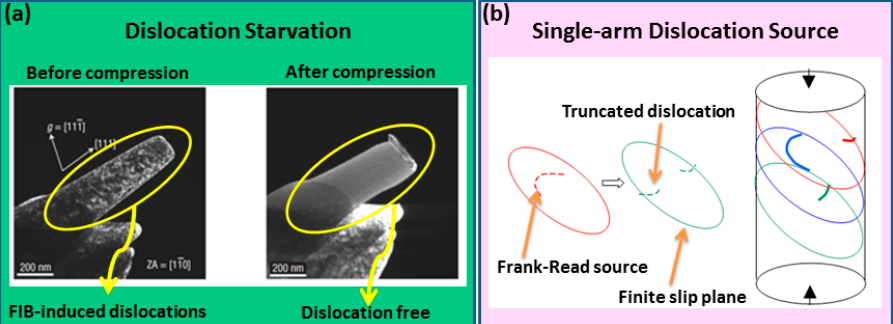
Figure 1. ( a ) Dislocation starvation state observed in a submicron pure Ni pillar [2] ( Reprinted